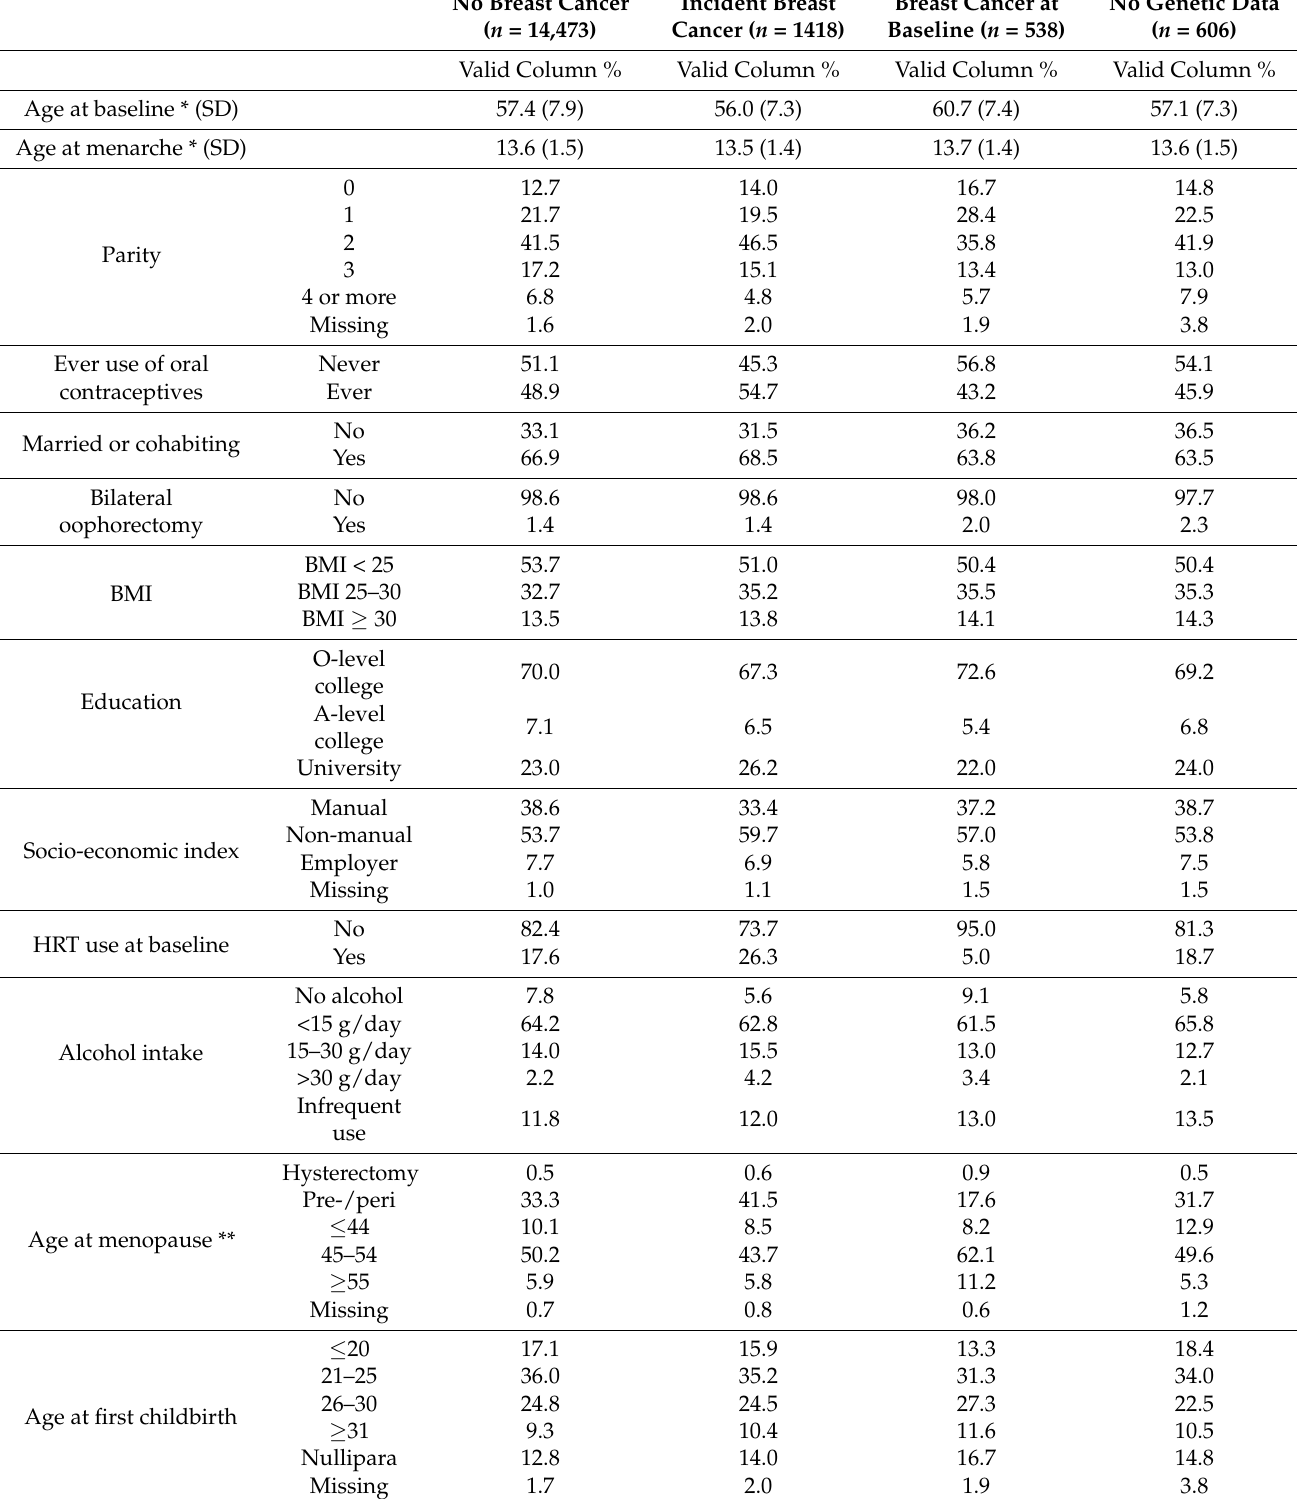
Table 1. Established and potential risk factors for breast cancer among included and excluded